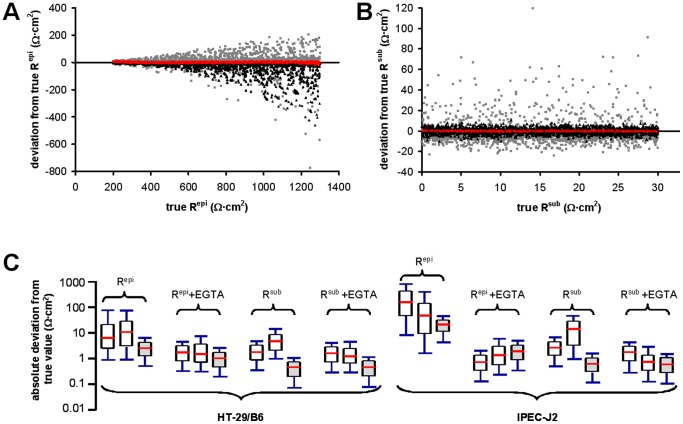
Comparison of M1, M2 and ANN precision with model impedance spectra.
A,B) Deviations of estimated Repi (A) and Rsub (B) values (estimated minus true value), using method M1 (grey ▪), M2 (black ▴) and the appropriate ANN (red •) are plotted against the respective known target value. Values refer to HT-29/B6 cells in the absence of EGTA. For all other conditions see Fig. S5. C) Box plot of absolute deviations (|estimated minus true value|) for all eight conditions. Each data set was evaluated using M1 (left), M2 (middle) and the appropriate ANN (right, shaded). Midline: median; box, 1st and 3rd quartile; tails, minimum and maximum. Except for the  which performs significantly worse than M1 (p<<0.01), all ANNs perform highly significantly better (p<<0.01) than M1 and M2 (Wilcoxon signed-rank test).